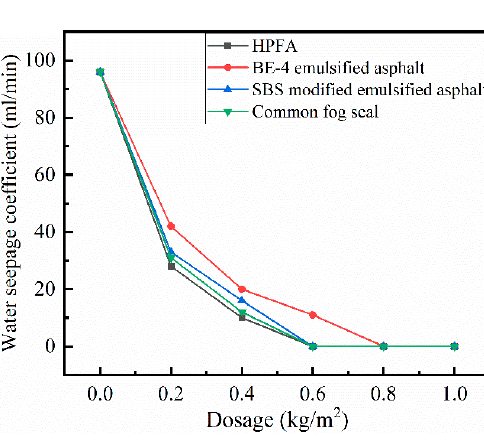
Figure 19. Water seepage coefficient of fog seal with different dosage.